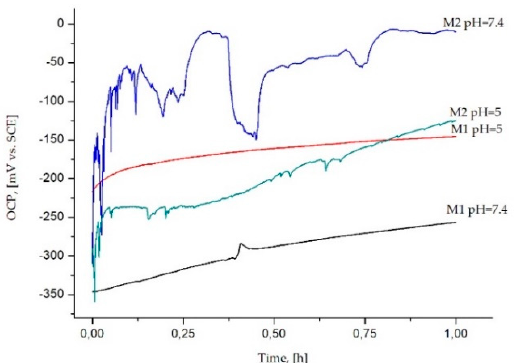
Figure 3. Examples surface topography analysis ( a ) 3D view of atomic force microscopy (AFM) scan from 10 × 10 µm 2 M1; ( b ) 3D view of AFM scan from 10 × 10 µm M2. The mean value of R a parameter for uncoated samples (M1) was R a = 21 nm and for